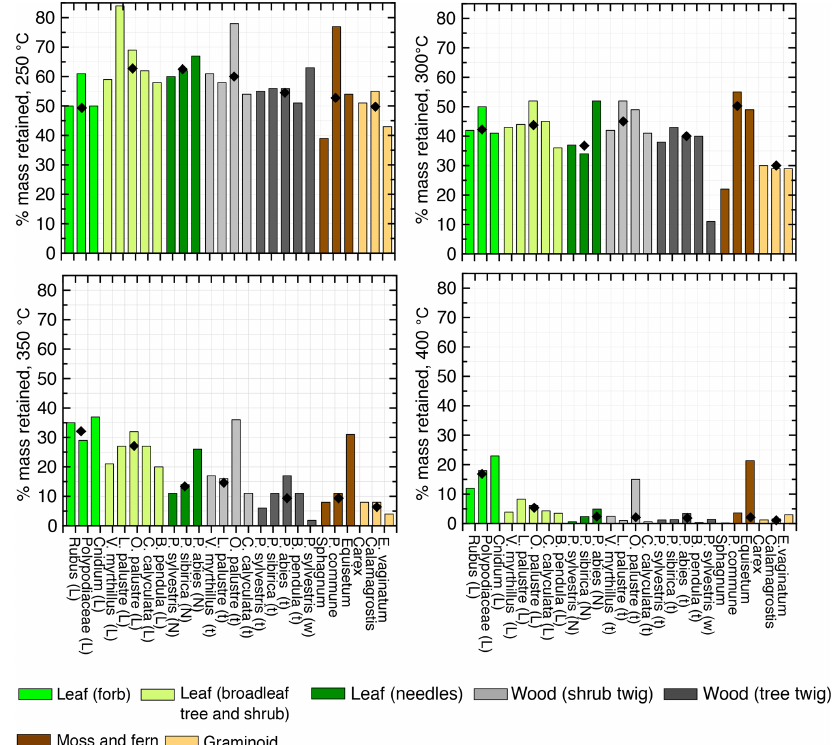
Figure 1. The percent of charred mass retained after burning known plant species from Siberia in a muffle oven at 250, 300, 350, and 400 ◦ C. The abbreviations used in the figure are as follows: L – leaf, N – needles, t – twig, and w – wood. The median mass retained for similar fuel types (identified by the same colour) is reported as black